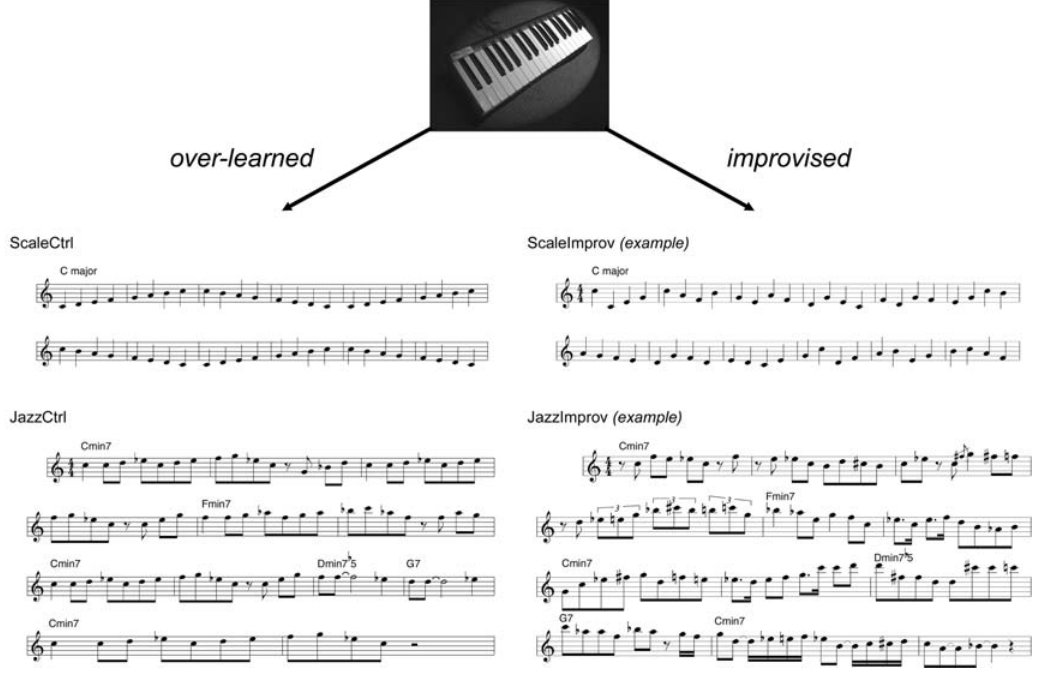
Figure 1. Low complexity (Scale) and high complexity (Jazz) experimental paradigms used to study spontaneous musical creativity. In the upper portion of the figure, the non-ferromagnetic MIDI piano keyboard that was used during functional MRI scanning is shown. This keyboard had thirty five full-size piano keys which triggered high-quality piano sound samples generated outside of the scanner, which were immediately routed back to the musicians using audiophile quality electrostatic earphone speakers. During scanning, subjects were randomly cued to play either the over-learned control condition or to improvise spontaneously. For Scale’s control condition, subjects repeatedly played a one octave ascending and descending C major scale in quarter notes for the duration of the block (ScaleCtrl, upper left). For Scale’s improvisation condition, subjects improvised in quarter notes only, selecting all notes from within one octave and from the C major scale notes alone (example shown under ScaleImprov, upper right). For Jazz’s control condition, subjects played a novel melody that was memorized prior to scanning (JazzCtrl, lower left). For Jazz’s improvisation condition, subjects improvised using the composition’s underlying chord structure as the basis for spontaneous creative output (example shown under JazzImprov, lower right). Note that for JazzCtrl and JazzImprov, eighth notes are typically performed with a ‘‘swing’’ feel that is not accurately represented using standard musical notation, in both the control and improvisation conditions. Audio samples of the four musical excerpts shown here are provided in Supporting